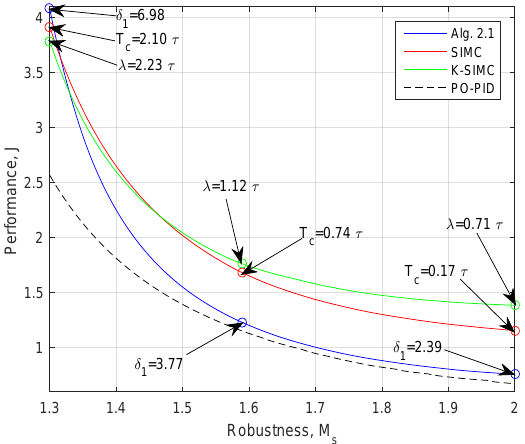
Figure 6: Example 3.3: Performance vs. robustness, J vs. M s trade-off curves. Comparing Alg.